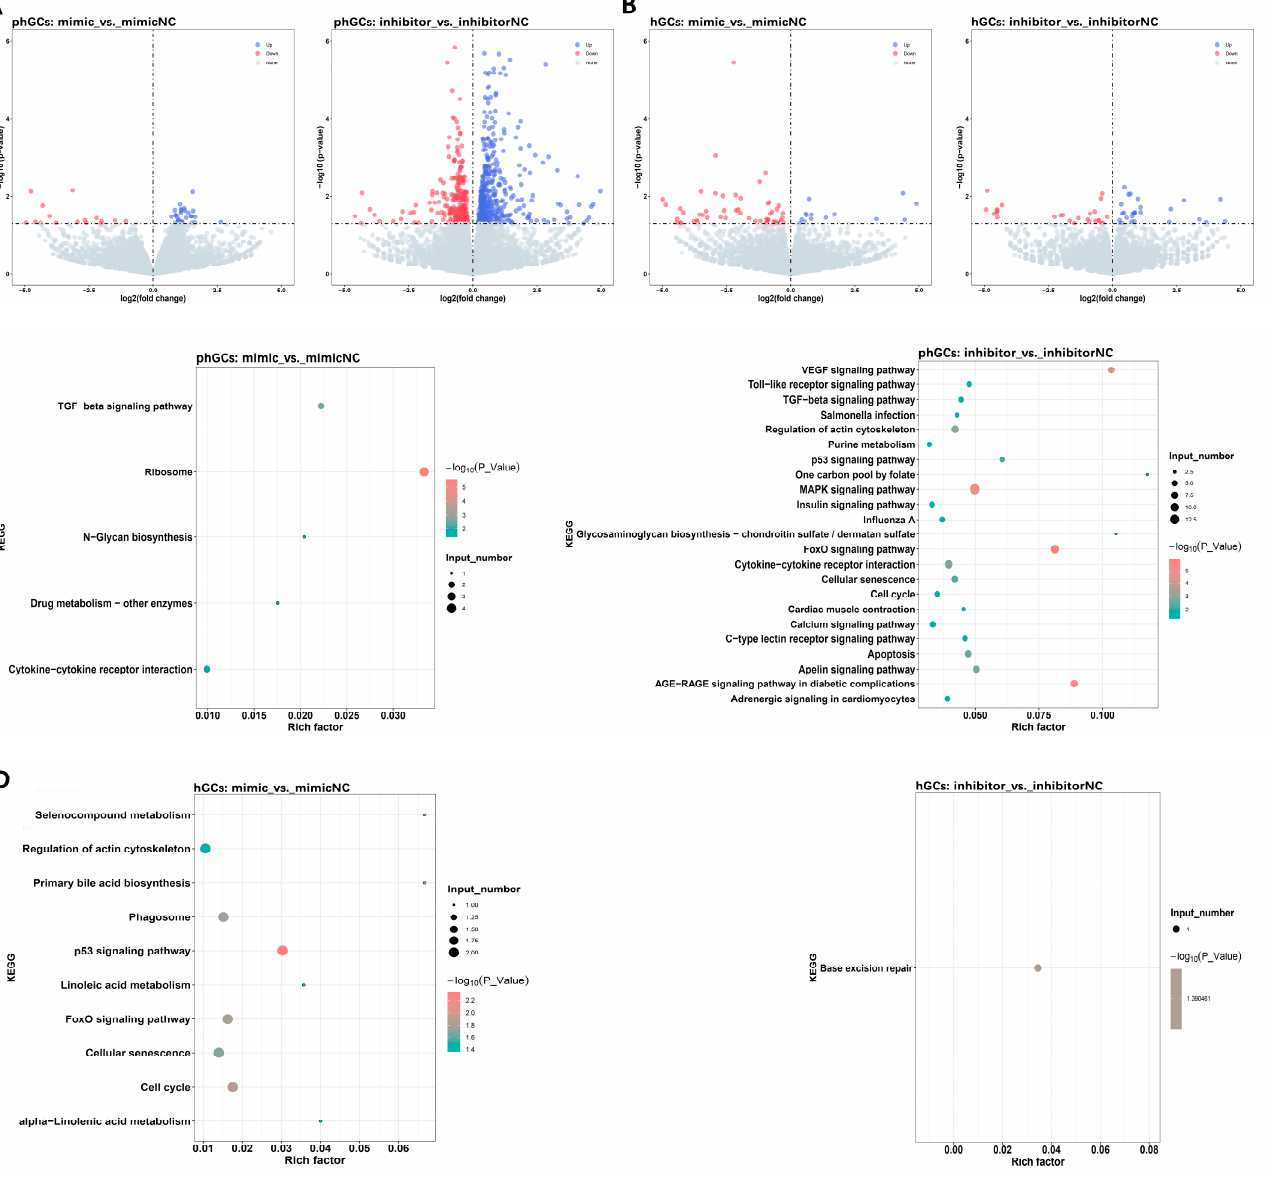
Figure 4. The effect of miR-202-5p on mRNA expression profiles of phGCs and hGCs. Volcano plot of Figure 4. The e ff ect of miR-202-5p on mRNA expression pro fi les of phGCs and hGCs. Volcano plot DEGs identified in phGCs ( A ) and hGCs ( B ); the significantly enriched KEGG pathways of DEGs of DEGs identi fi ed in phGCs ( A ) and hGCs ( B ); the signi fi cantly enriched KEGG pathways of DEGs identified in phGCs ( C ) and hGCs ( D identi fi ed in phGCs ( C ) and hGCs ( D ).